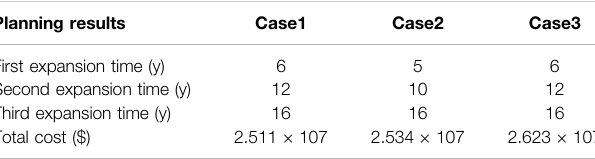
Table 2 | Comparison of the expansion results for each con fi guration. Planning results